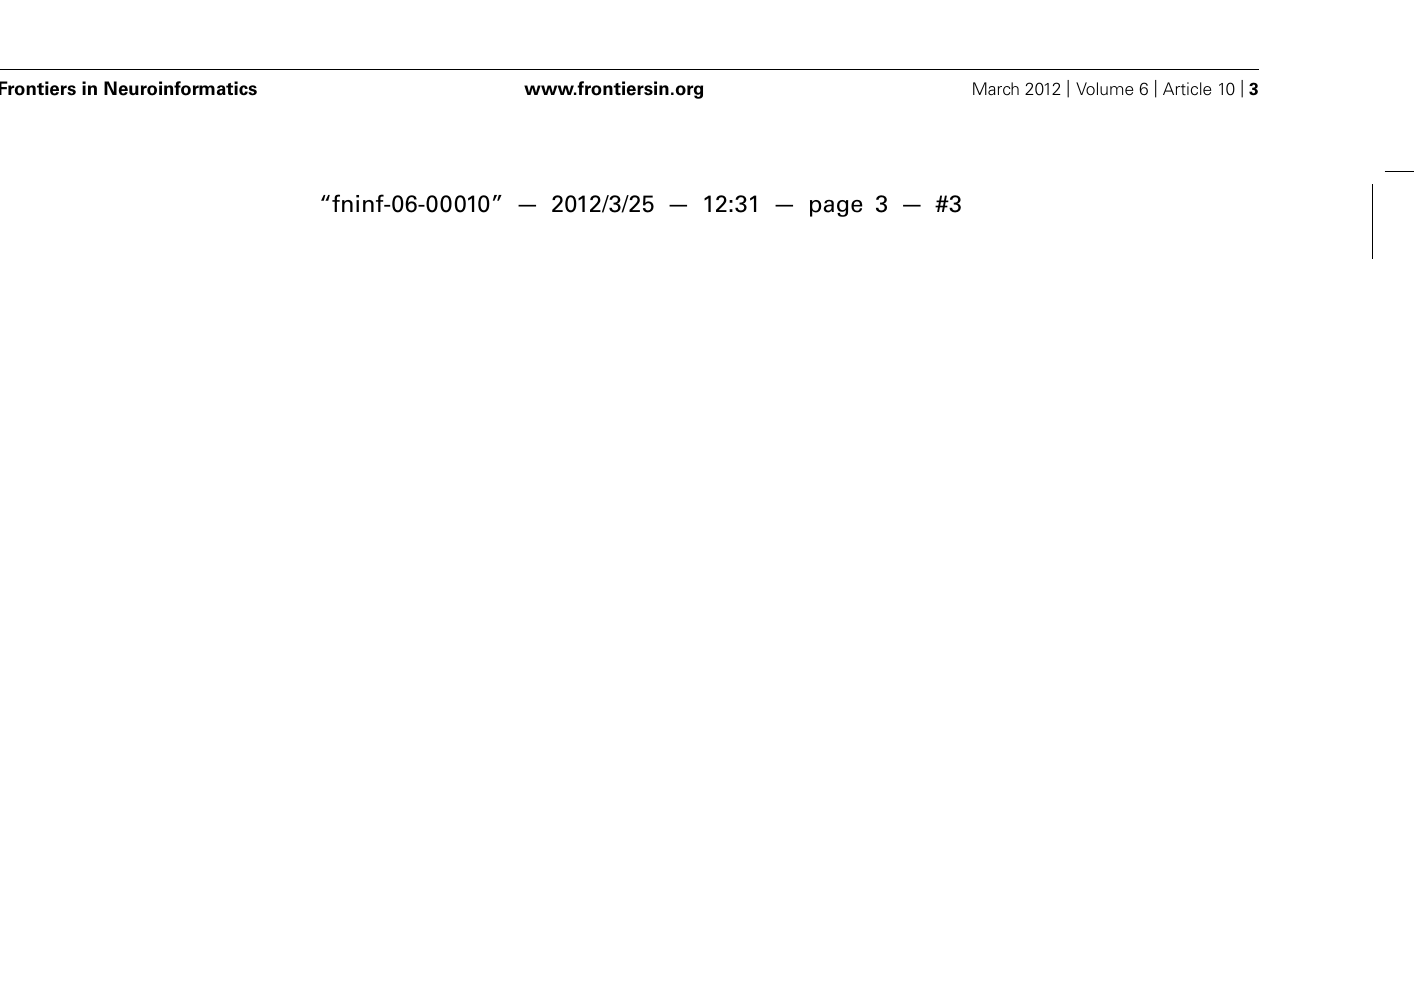
FIGURE 1 | Schematic of preprocessing and analyses for both structural GMD images and rs-functional